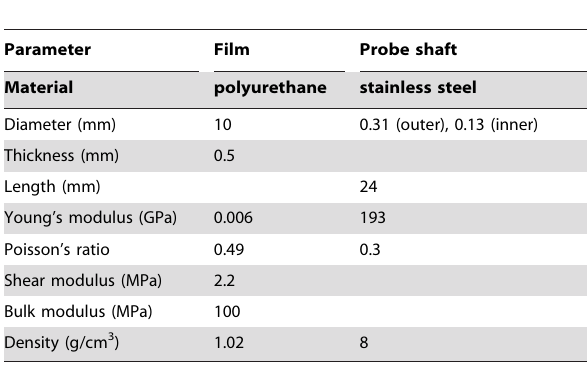
Table 1. Parameters used in the FEM